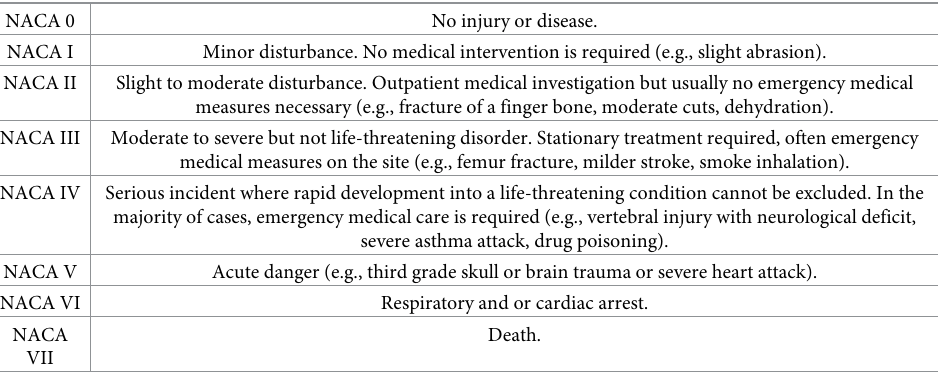
Table 1. NACA-Score (National Advisory Committee for Aeronautics Score) [13,